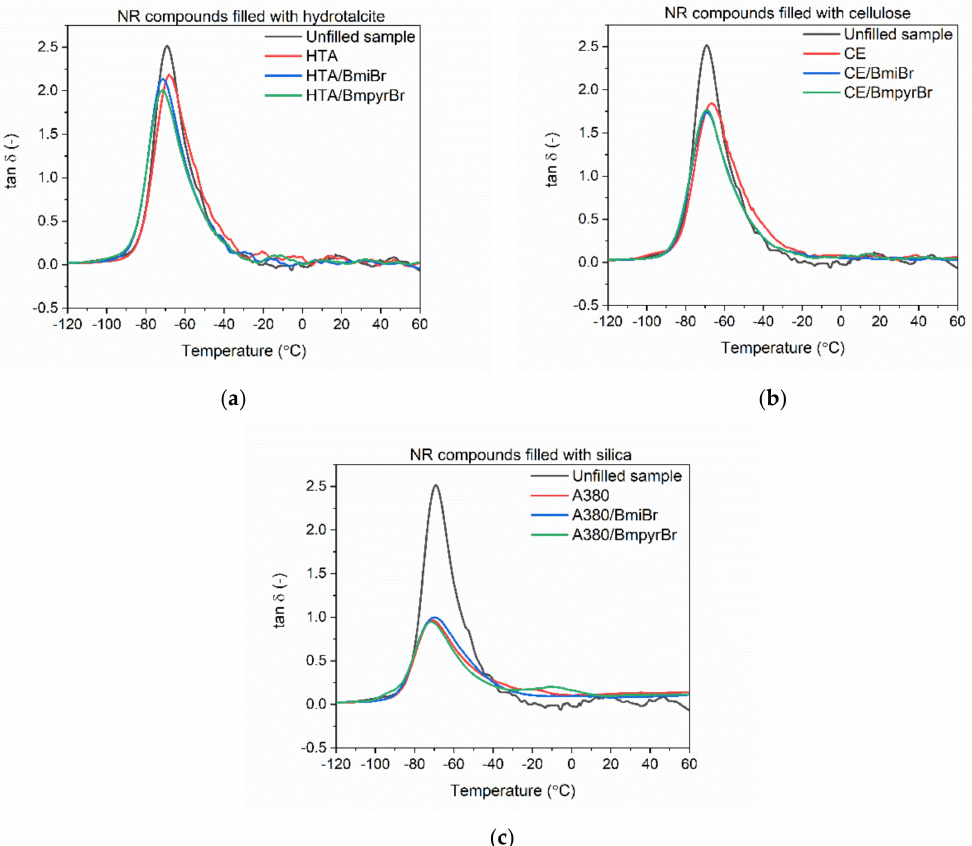
Figure 7. Loss factor (tan δ ) curves versus temperature for NR vulcanizates filled with: ( a ) HTA; ( b ) CE; ( c )